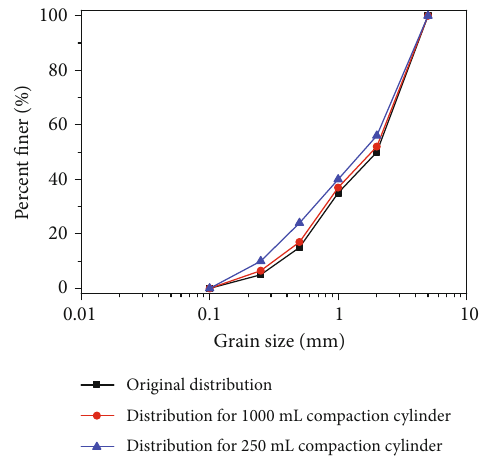
Figure 8: Grain size distribution curves for 250 and 1000 mL compaction